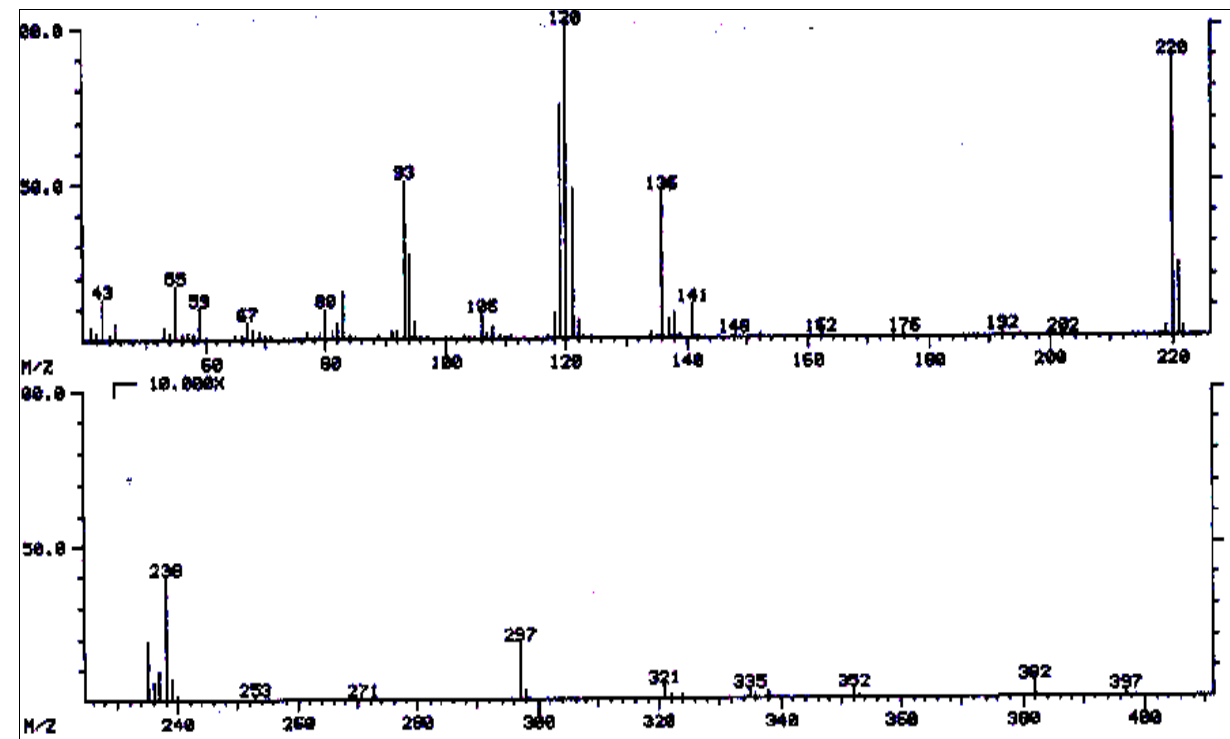
Figure 14. Mass spectrum of echimidine/heliosupine.